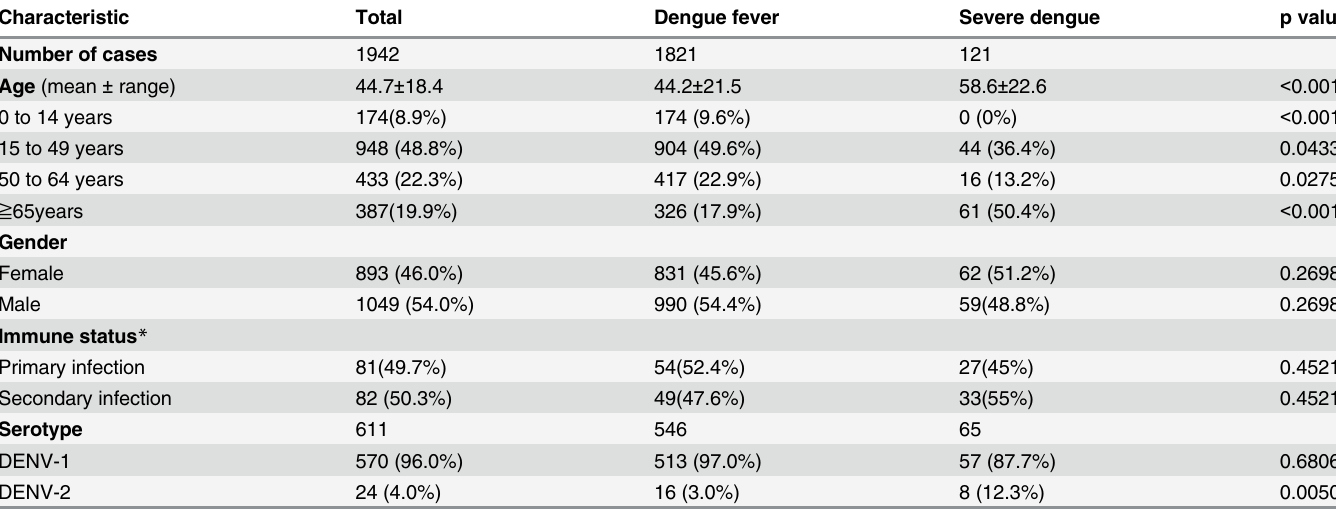
Fig 1. Number of the hospitalized dengue cases, Guangdong province, from 1 August to 31 October, 2014. doi:10.1371/journal.pone.0156548.g001 Table 1. Characteristics of hospitalized dengue cases during the